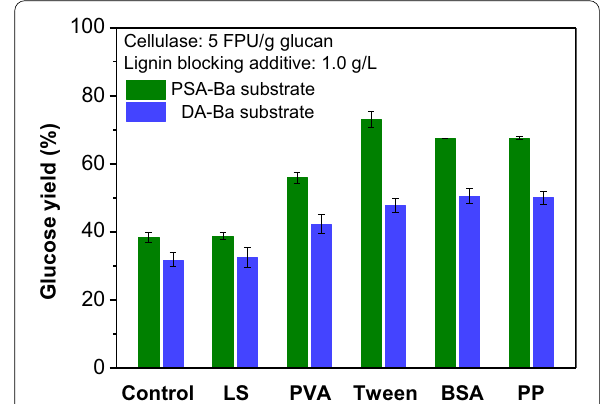
Fig. 2 Effects of different lignin-blocking additives on the glucose yields of PSA-Ba and DA-Ba substrates. The addition concentration of lignin-blocking additives, cellulase and β-glucosidase loadings in enzymatic buffer solution were 1.0 g/L, 5 FPU, and 10 CBU/g glucan, respectively. The pH value of enzymatic buffer solution was 5. LS, PVA, Tween, BSA, and PP refer to the lignosulfonate, poly(vinyl alcohol), Tween 20, bovine serum albumin, and peanut protein,